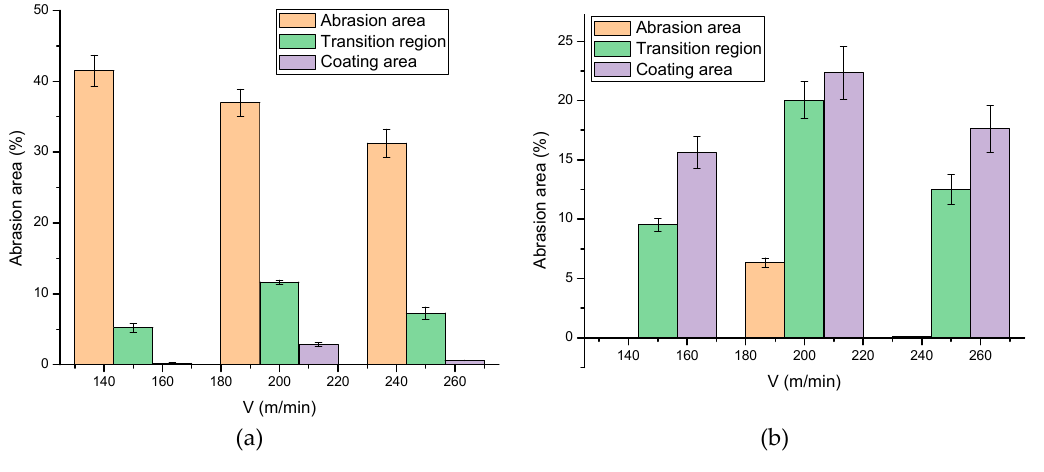
Figure 4. Relationship between element content and processing speed. ( a ) Adherence rate; ( b ) basic resin.